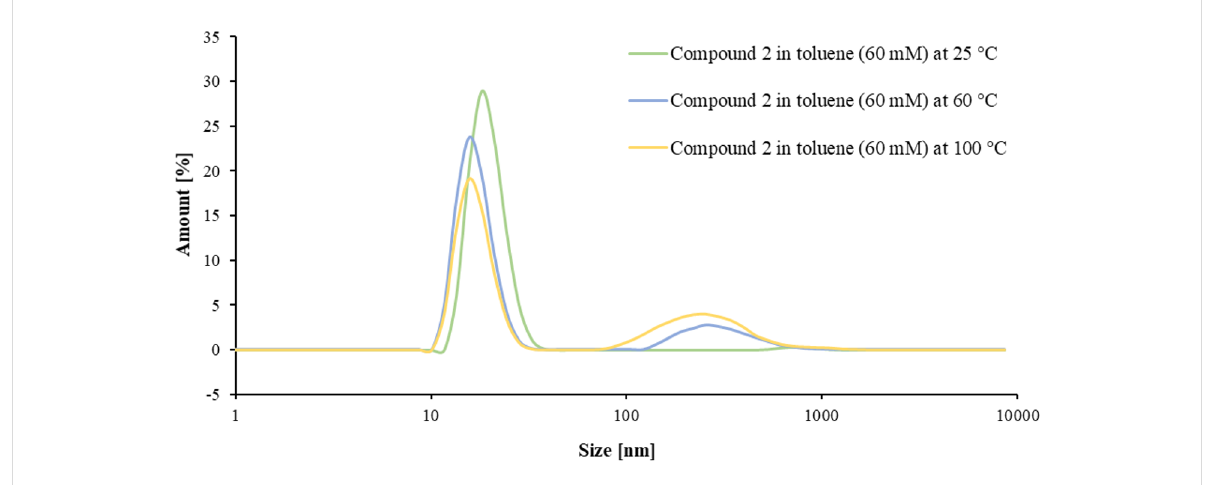
Figure 6: DLS measurement of compound 2 in toluene at 25 °C, 60 °C and 100 °C.